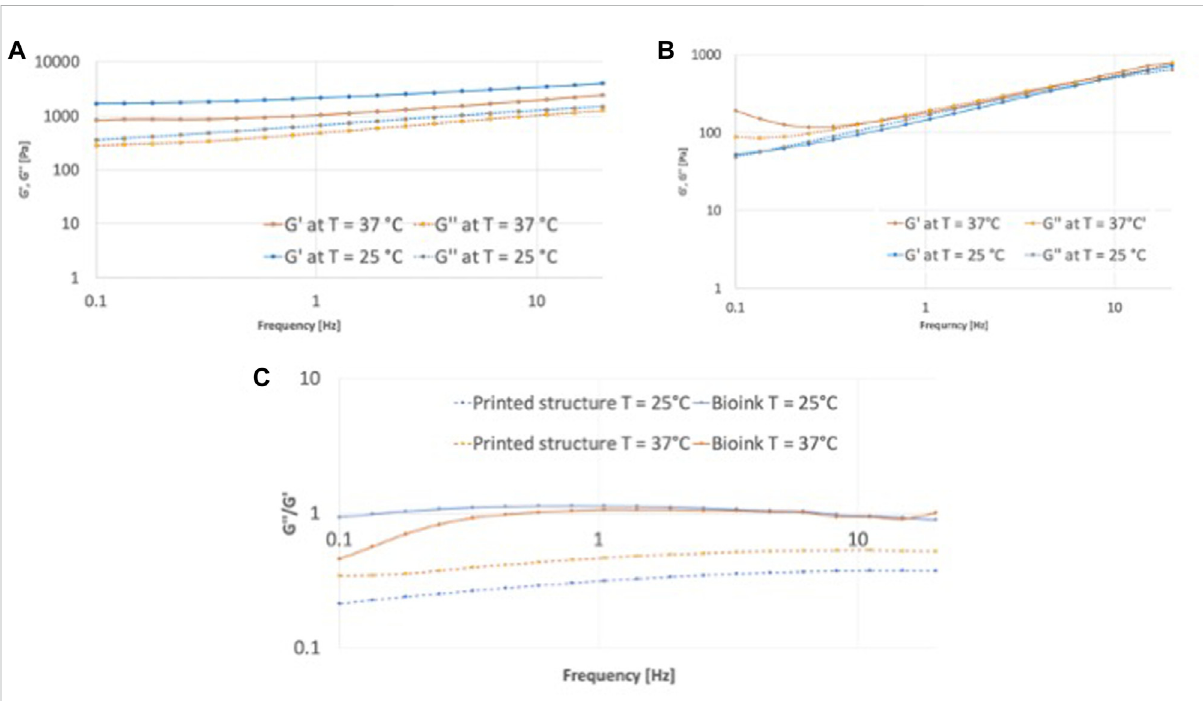
FIGURE 8 Rheological characterization in frequency sweep mood of the bionk and the printed structure. Comparison of storage modulus G ′ and loss modulus G ″ atT=25 ° C andT= 37 ° C oftheprinted structure in (A) andof thebioinkin (B) ; (C) tan δ , de fi ned as theratio ofG ” /G ′ ofbioinkand printed structure at T = 25 ° C and T = 37 ° C.